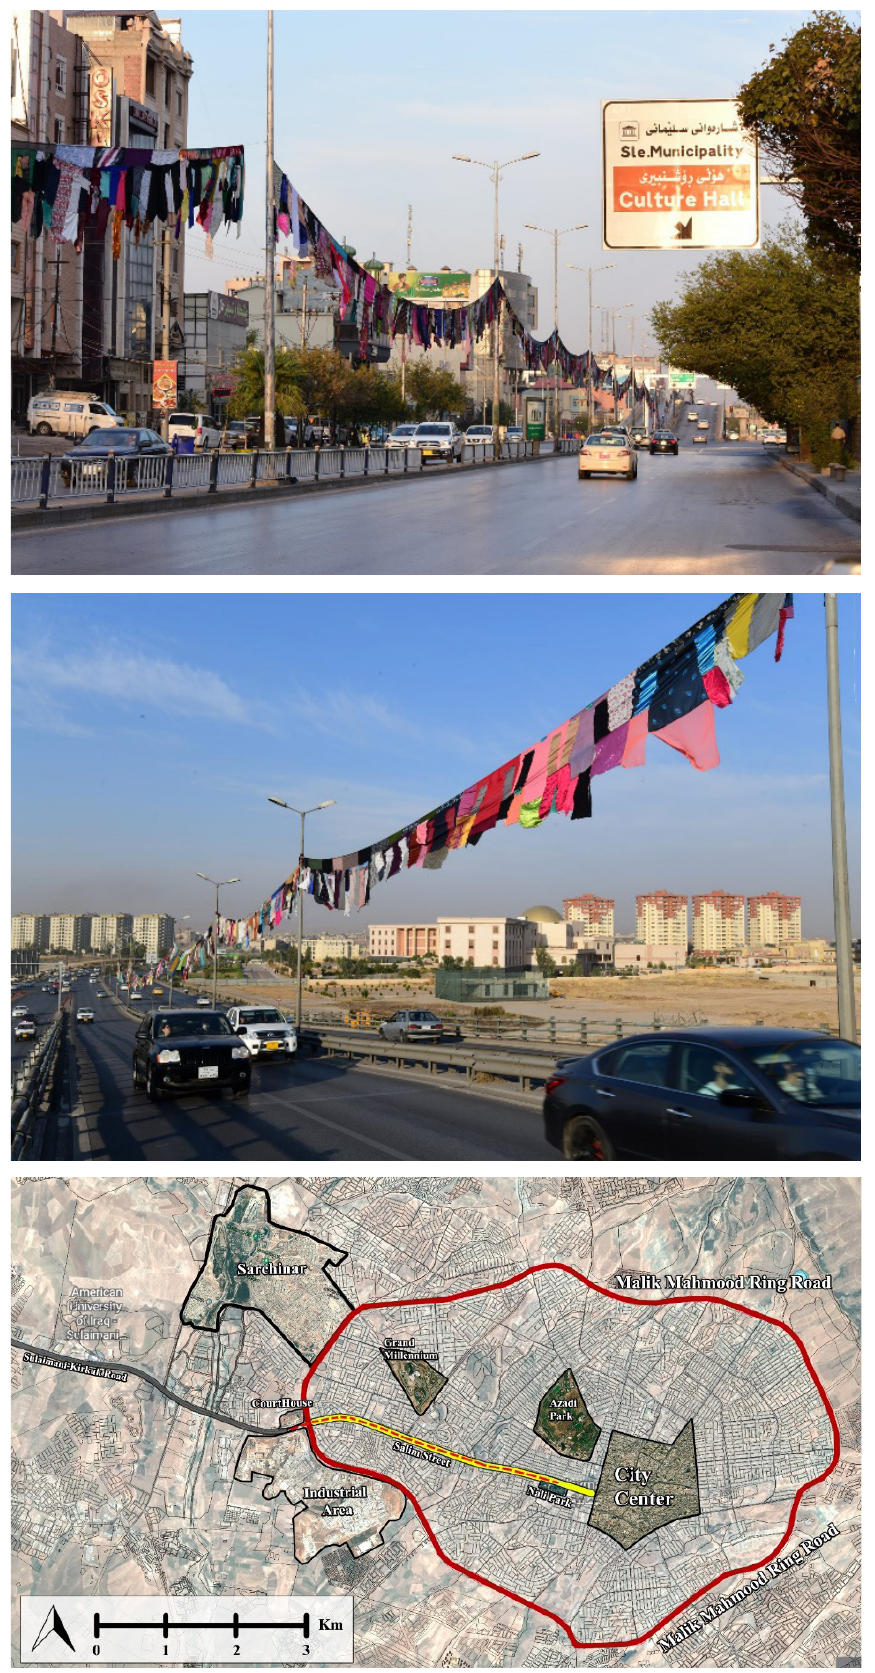
Figure 1. Feminist installation artwork and location along the course of Salim Street. Source: Photos taken from Abdulla (2020); map prepared by the